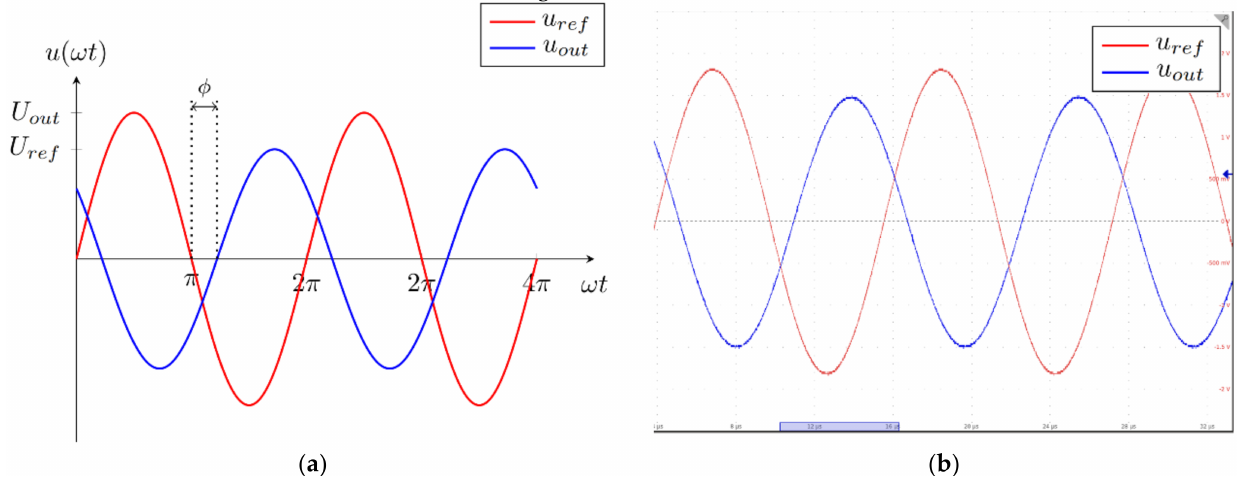
Figure 5. Voltage signals on the auto-balancing bridge. ( a ) Theoretical values, ( b ) measured values. Additional auxiliary circuits measure the amplitude of the input and output